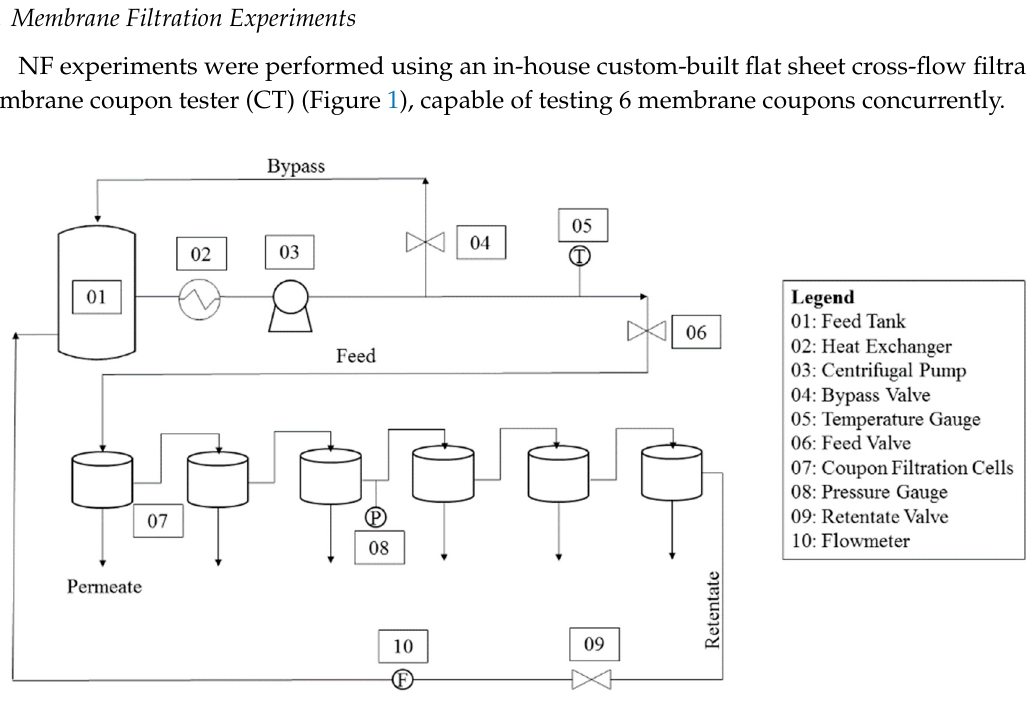
Figure 1. Cross flow nanofiltration setup.